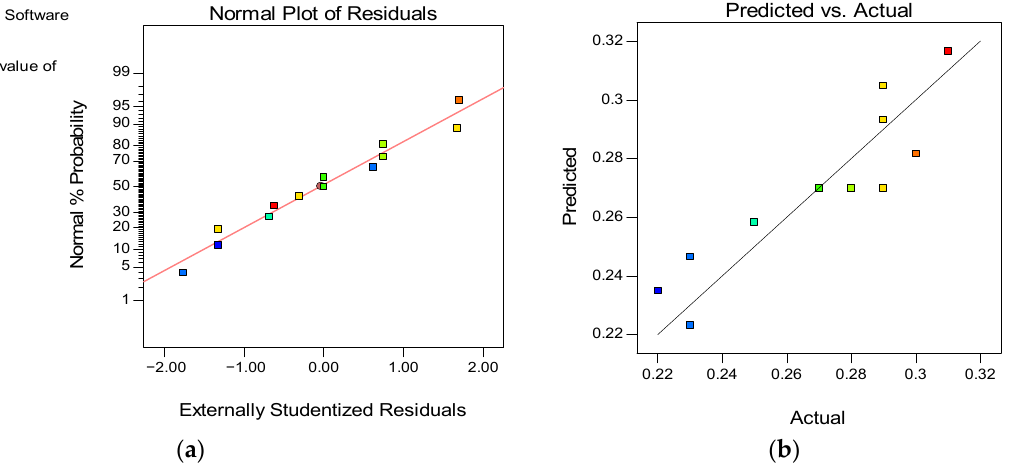
Figure 18. ( a ) The normal plot of residuals and ( b ) actual versus predicted plot for the OBA ‐ RECC PR model.